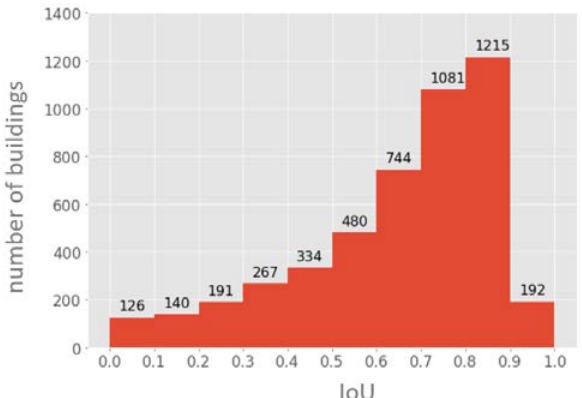
Figure 10. Histogram for IoU, where number of buildings were reported for each IoU